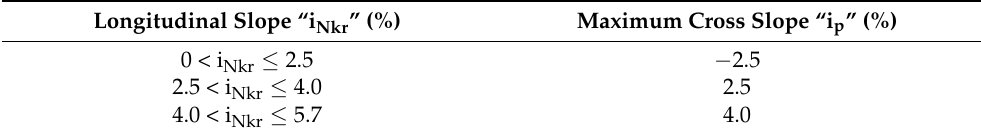
Figure 6. Circulatory roadway width (“b k ”) for single-lane roundabouts [10]. According to [10], the standard cross slope of the circulatory roadway is 2.5%. The cross slope is directed towards the outer edge of the intersection. The maximum cross slopes of the circulatory roadway (“i p ”) as a function of the slope of the intersection plane (“i Nkr ”) is shown in Table 2. At the same time, the largest total slope is 4% [10]. Table 2. Circulatory roadway slope